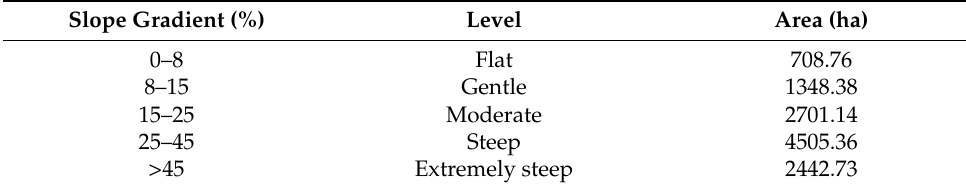
Table 3. Slope classes in the Rongga Sub-district